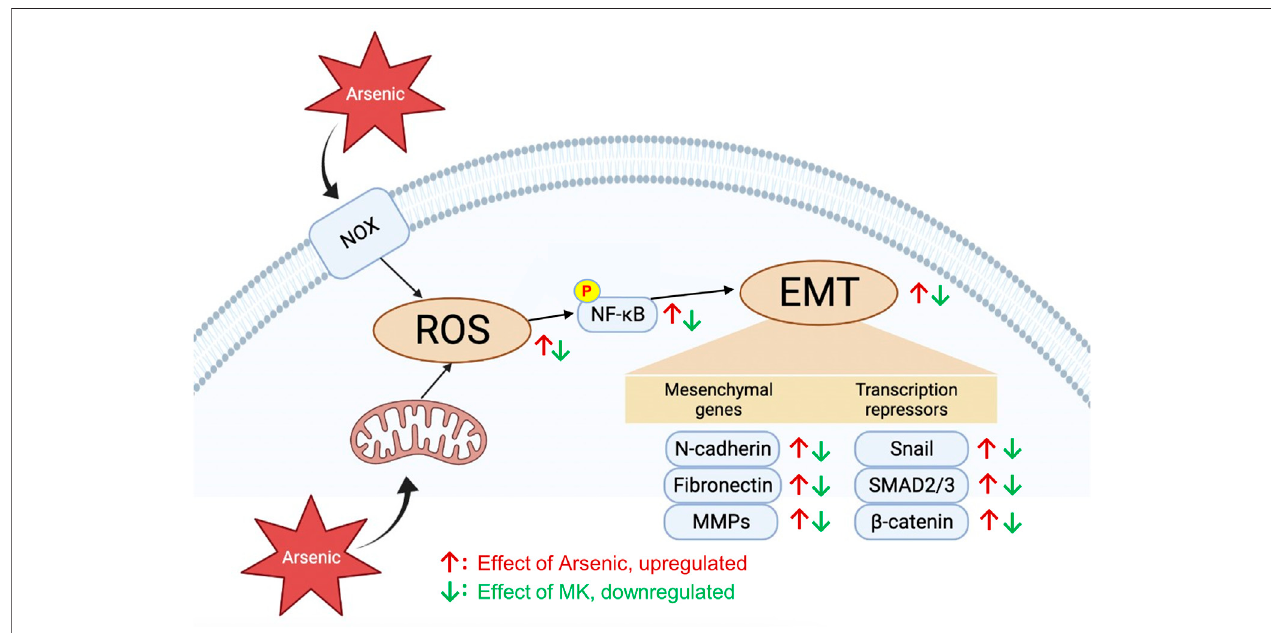
FIGURE6| Theeffectsandsignalingmoleculesinvolvedinmontelukast-mediatedattenuationofarsenic-inducedEMTchangesinhumanbronchialepithelialcells.